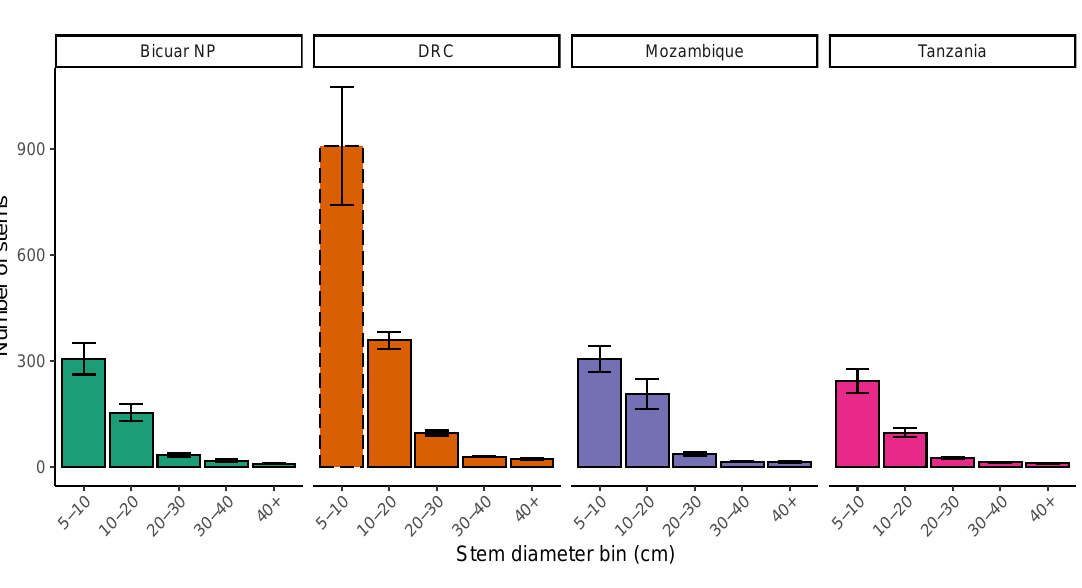
Figure 5. Ranked variation between plots in stem number within each site, with bars according to stem diameter class. Error bars are the mean ± 1 standard error. The dashed bar for the DRC 5–10 cm stem diameter class indicates that these measurements were estimated by extrapolating a linear regression of log stem abundance across the available stem diameter classes for